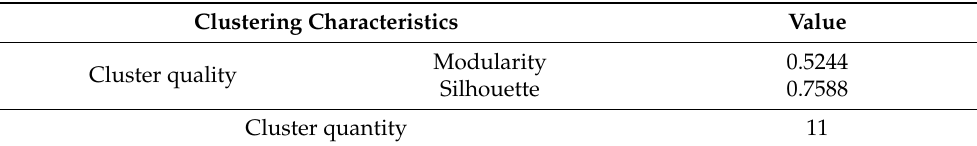
Table 5. Cluster information.